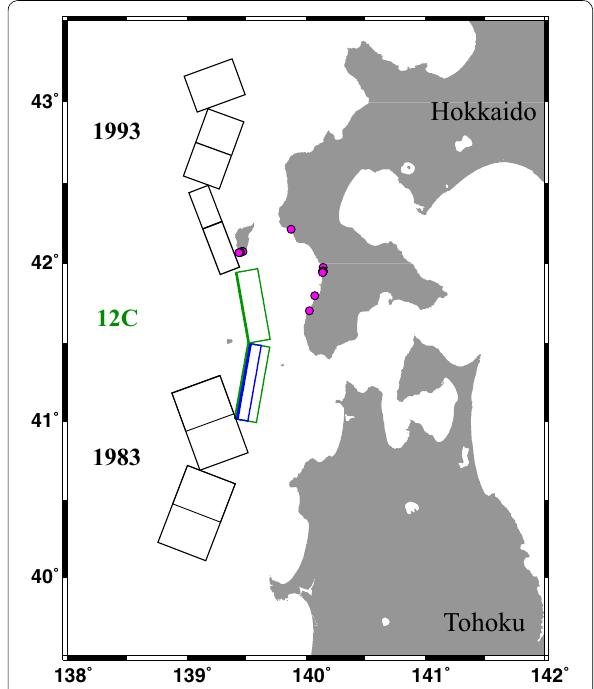
Fig. 4 Fault models of earthquakes that have occurred in southwestern Hokkaido in the Japan Sea: fault model of the 1993 Hokkaido Nansei-oki earthquake estimated by Tanioka et al. (1995), fault model of the 12th century earthquake estimated in this study, and fault model of the 1983 Japan Sea earthquake estimated by Satake (1989). Tsunami deposit distributions are shown in pink